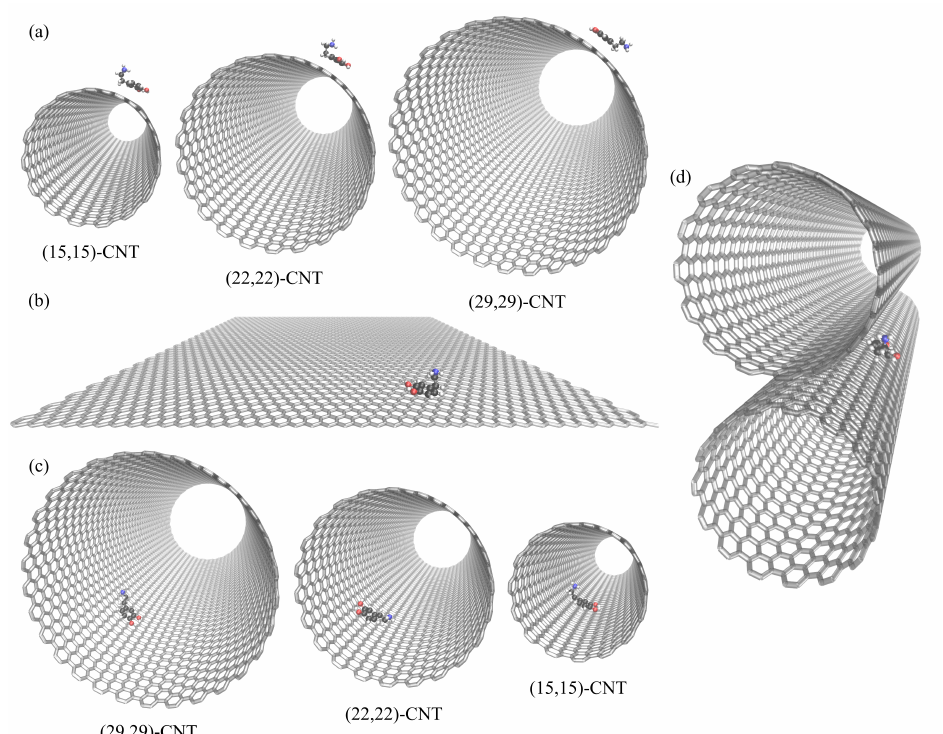
Figure 1. Simulated CNT and graphene surfaces. DA is shown on ( a ) the exterior surfaces of CNTs of varying curvatures, ( b ) flat graphene, and ( c ) the corresponding CNT interiors. In ( d ), DA diffuses along the exterior groove formed by two parallel ( 15,15 ) -CNT nanotubes. The dimensions of the CNTs are listed in Table S1, and the solvating water molecules were omitted here for visual clarity.